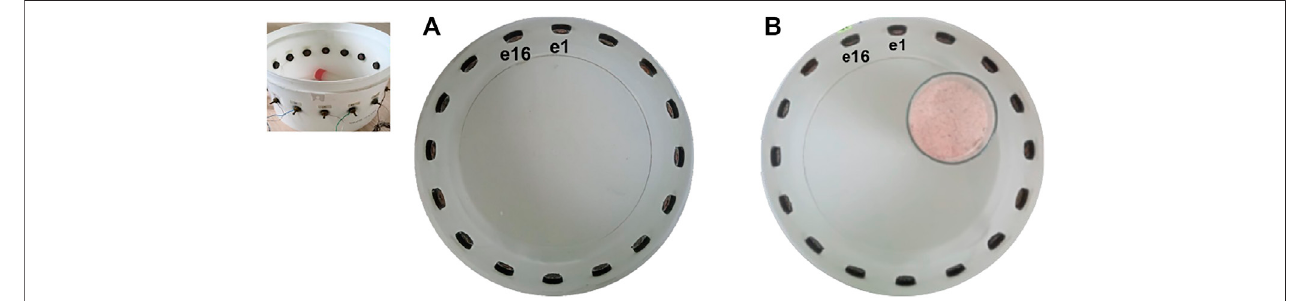
FIGURE 2 | Block diagram of IMPETOM-Clínico. In order to evaluate the effects of multiplexers, they are omitted to obtain impedance values (and resulting reconstructed images) which are then compared to the images obtained with the complete circuit. DDS used is AD9833; MC33077 is the operational ampli fi er that we used for the Howland current source, both band-pass fi lters include 30 kHz, but the band-pass fi lter prior to the measurement has a quality factor of Q = 37.